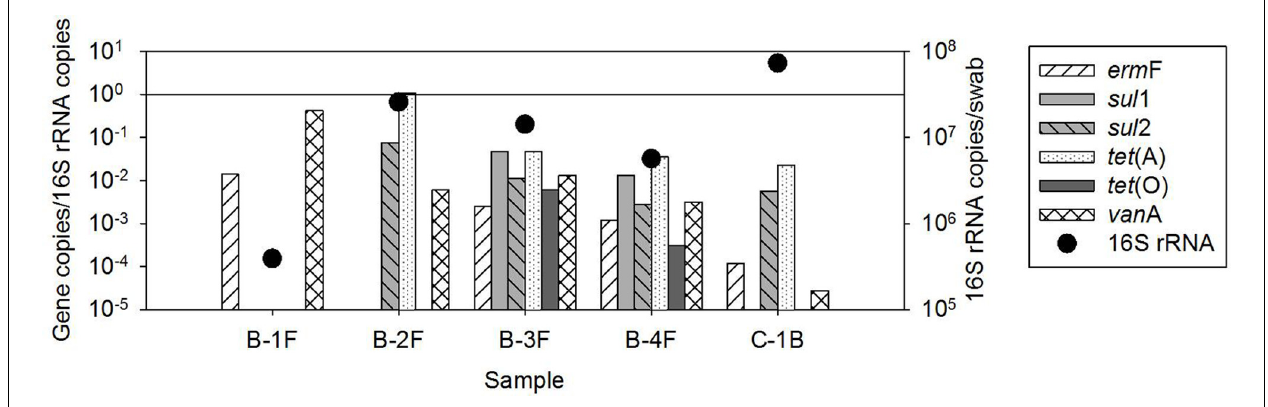
FIGURE 2 | Quantification ofARGs in biofilm samples available from recycled water distribution systems B and C. Bars represent absolute ARG copies per swab, symbols represent 16S rRNA gene copies per swab.